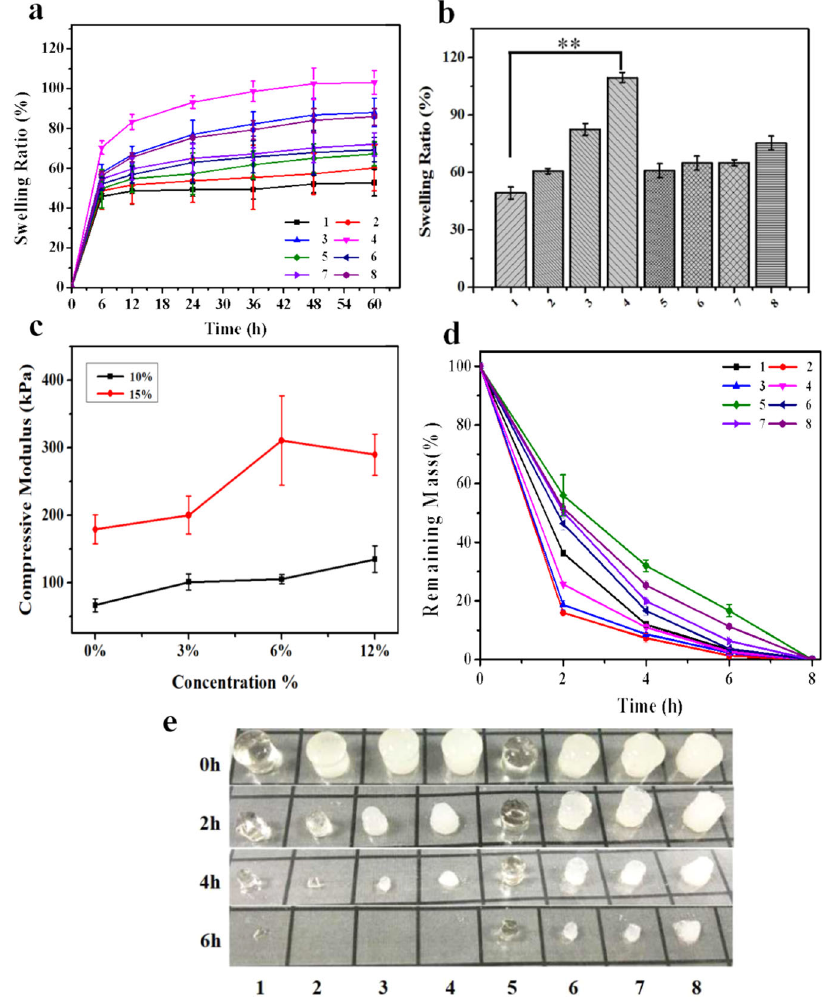
Fig. 2 Analysis of physical properties of hydrogels 1 – 8. a Relative mass increase (%) as function of time due to water uptake and swelling of materials 1 – 8 during incubation in PBS buffer at 37 °C. In both series of materials (A and B), the formulations with the largest content of DCM (i.e., 4 and 8, respectively) show the fastest and highest degree of swelling. b Relative mass increase of materials 1 – 8 at equilibrium. The water content increase in the Series A and B, showing that added DCM contributes to the hydrophilic character of the hydrogels. c Apparent Young ’ s modulus of the hydrogels 1 – 8. In both Series A and B, it is seen that increased DCM content correlates with increased stiffness. d , e Experimental data on enzymatic degradation of the materials 1 – 8 (by type-IIcollagenase). The data reveal the biodegradable nature of the materials. (Error bars: ± SD, * p < 0.05, ** p < 0.01, *** p <